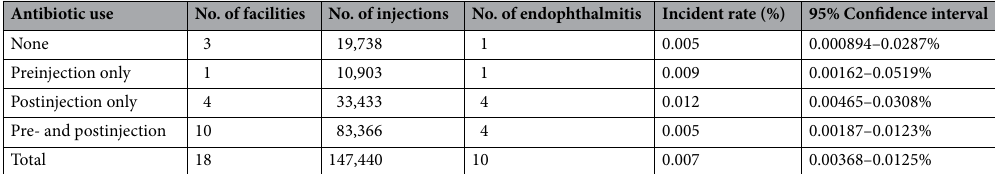
Table 2. The incidence of endophthalmitis in the four groups as defined by the use of topical